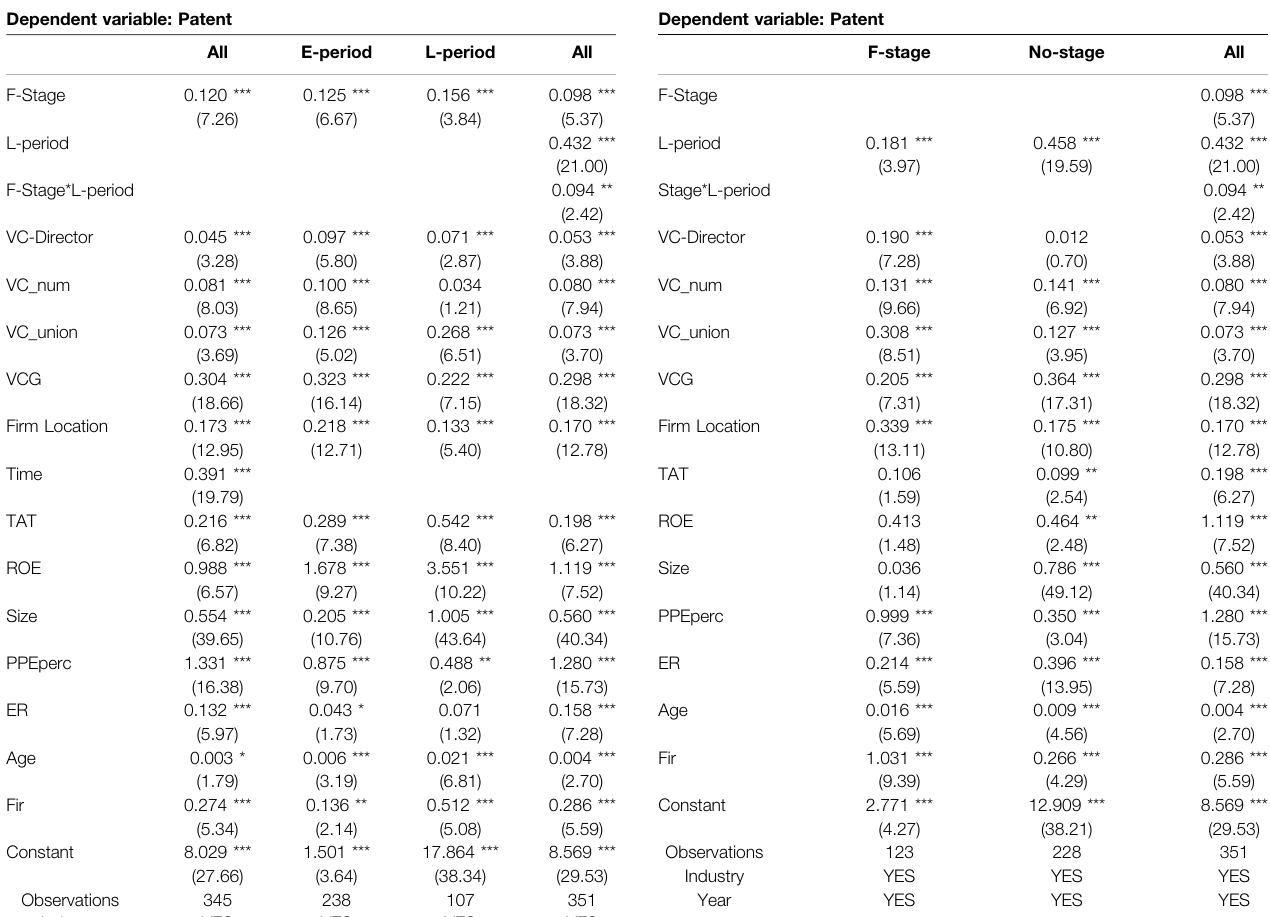
TABLE 9 | Investment regression results by stage. TABLE 10 | Investment regression results by